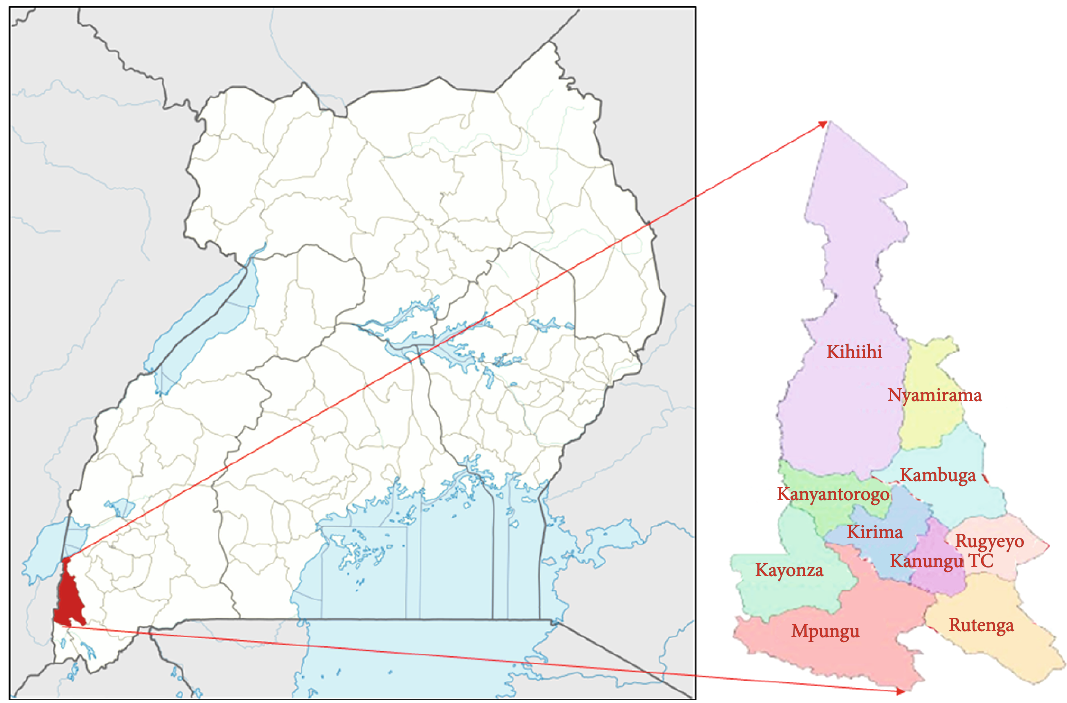
Figure 1: Map of Uganda and Kanunga District, picture sourced from Google